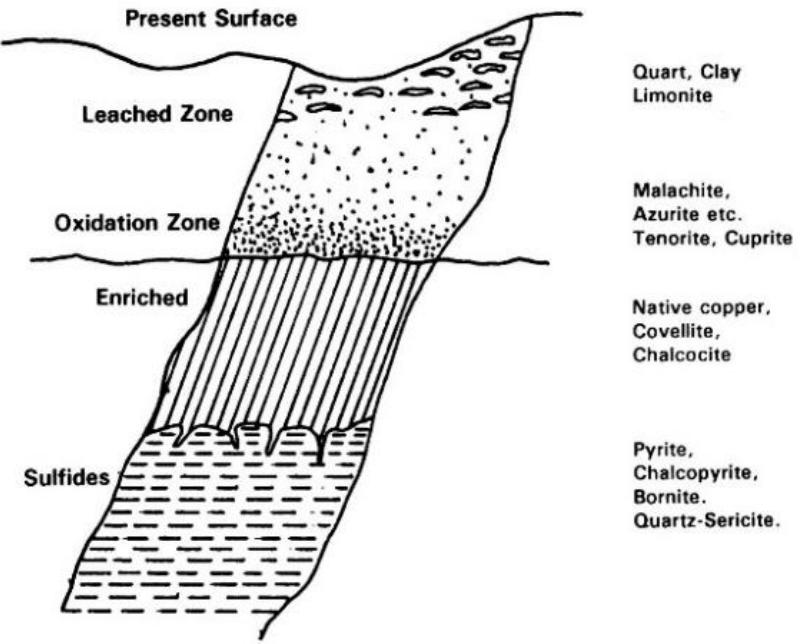
Figure 3. Illustrated copper ore deposit for comparison to the Eh-pH diagram to the right (Dudas et al. [10]).